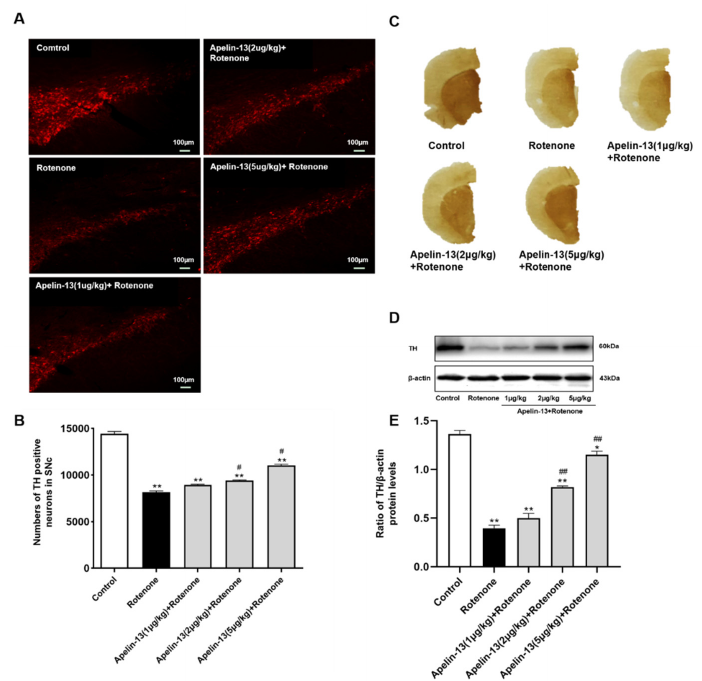
Figure 13. E ff ects of apelin-13 on the degeneration of nigrostriatal dopaminergic neurons in rats with rotenone administration. The in vivo Parkinson’s disease (PD) model was established in Wistar rats by the administration of rotenone. ( A , B ) The TH-positive cells in the substantia nigra (SN) of the rats